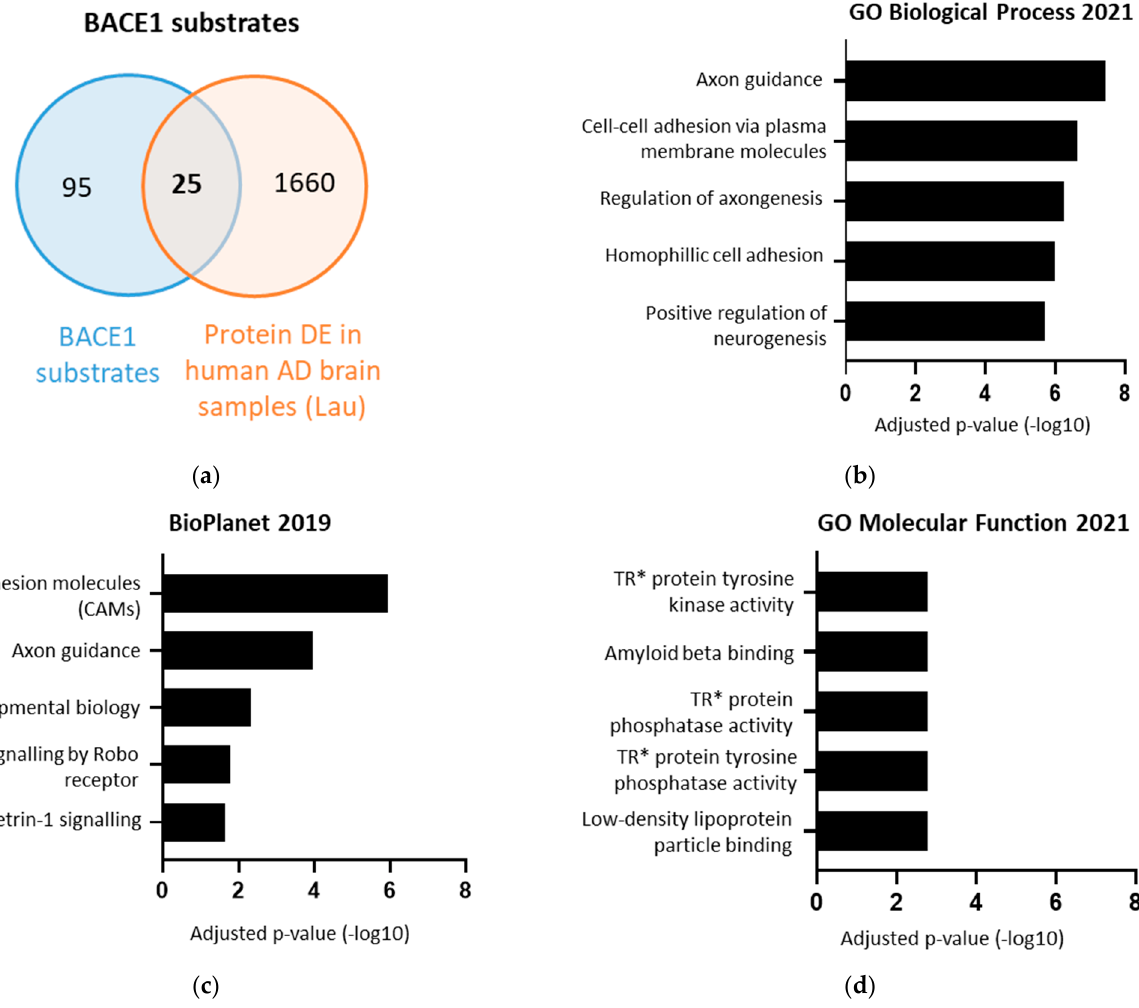
Figure 4. The 25 BACE1 substrates differentially expressed in Alzheimer’s disease (AD). ( a ) Venn diagram overlaying 120 BACE1 substrates with 1685 proteins differentially expressed in AD [38]. showing log of adjusted p -value. * TR = transmembrane